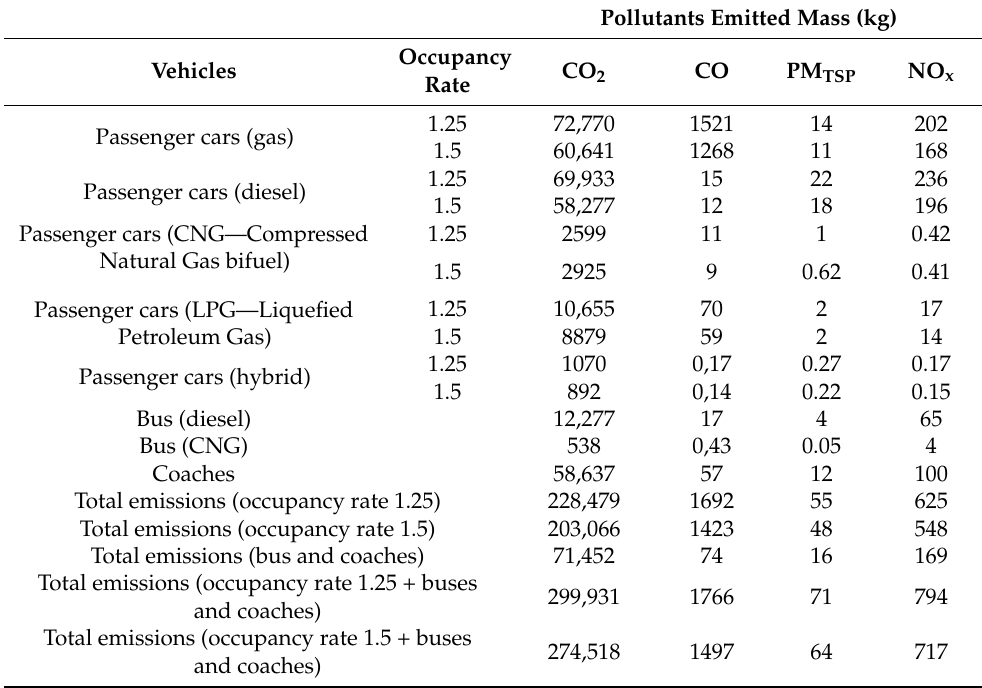
Table 7. Pollutants emitted per vehicle type and prevalent occupancy rate, 2019, determined by the COPERT